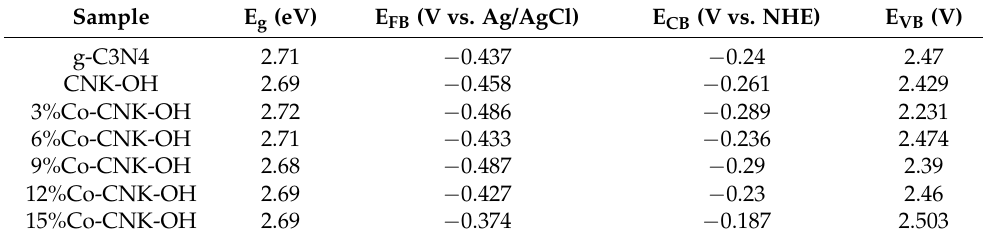
Table 2. E g , E FB , E CB, and E VB of g-C 3 N 4 , CNK-OH and Co-CNK-OH.